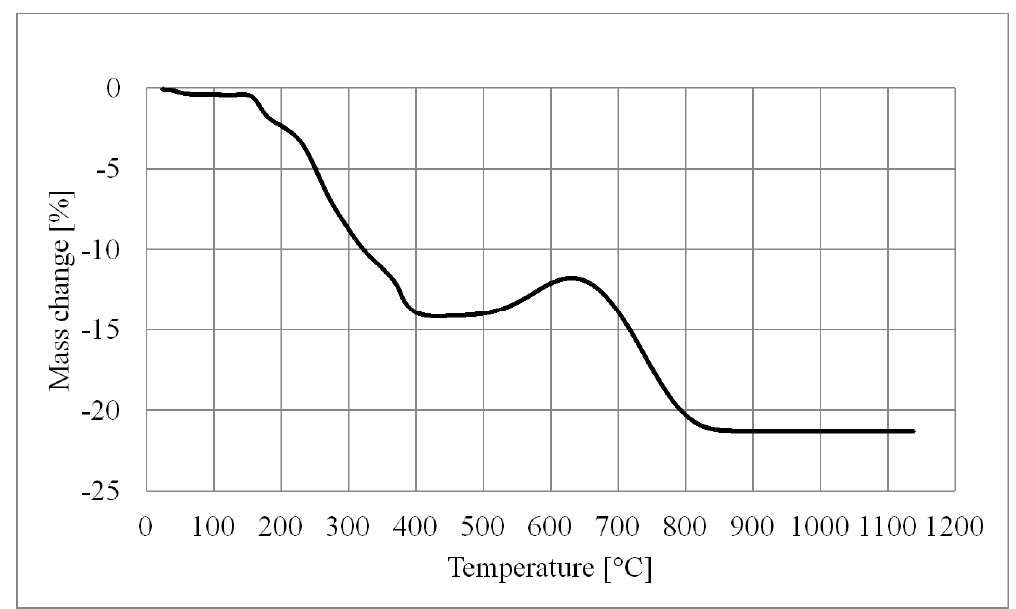
Figure 7. Thermogravimetric analysis of tape casted tape in air, heating rate 5